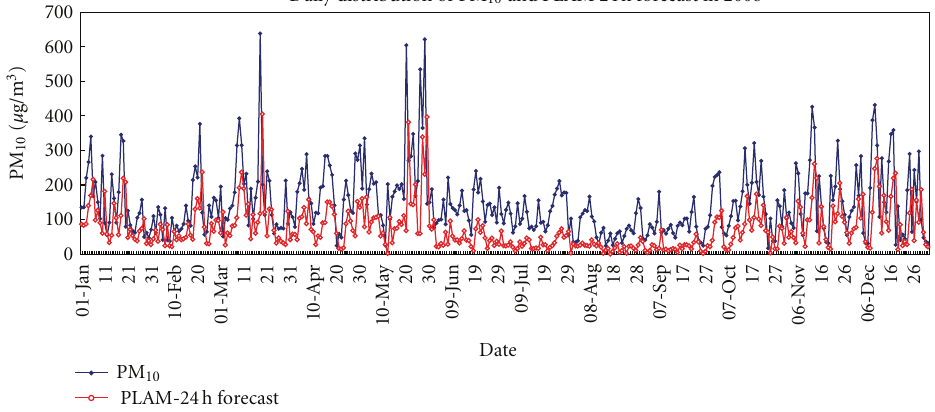
Figure 4: Daily PLAM distribution in 24 h forecasts, PM 10 observed at NCOB from 1 January to 31 December